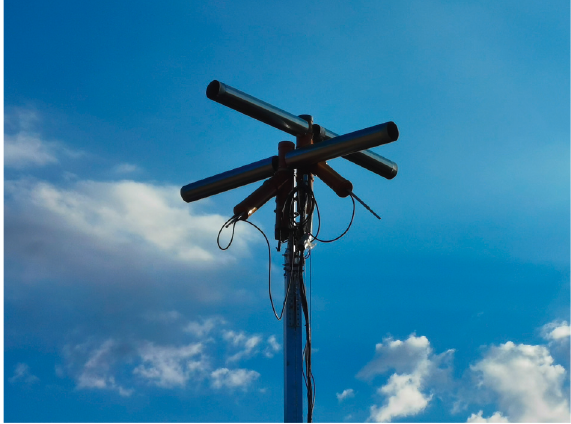
Figure 8: The two identical adapted shorted dipoles shifted by 90 ° in the horizontal